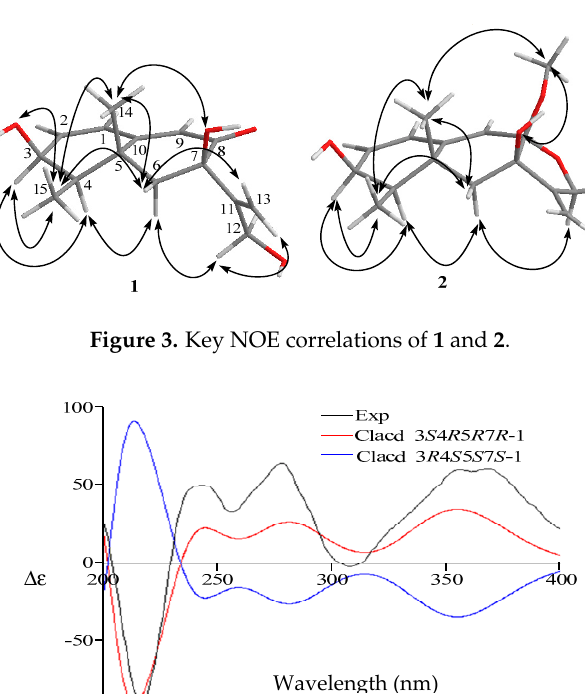
Figure 2. Key 1 H- 1 H COSY and HMBC correlations of 1 and 2 .